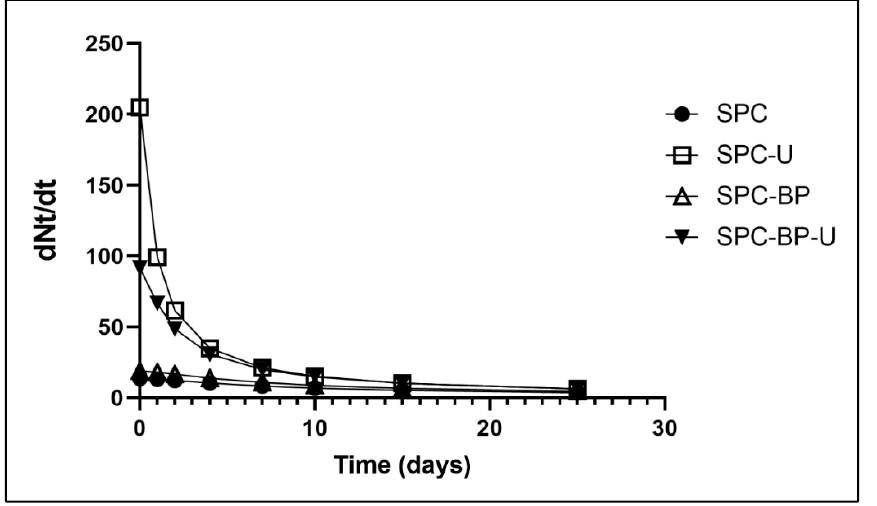
Figure 12. Change of total nitrogen release rate upon increasing the SPC-based composite pellets- water contact